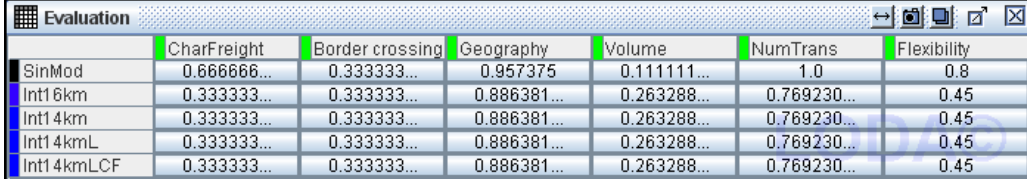
Figure 4. Logistic